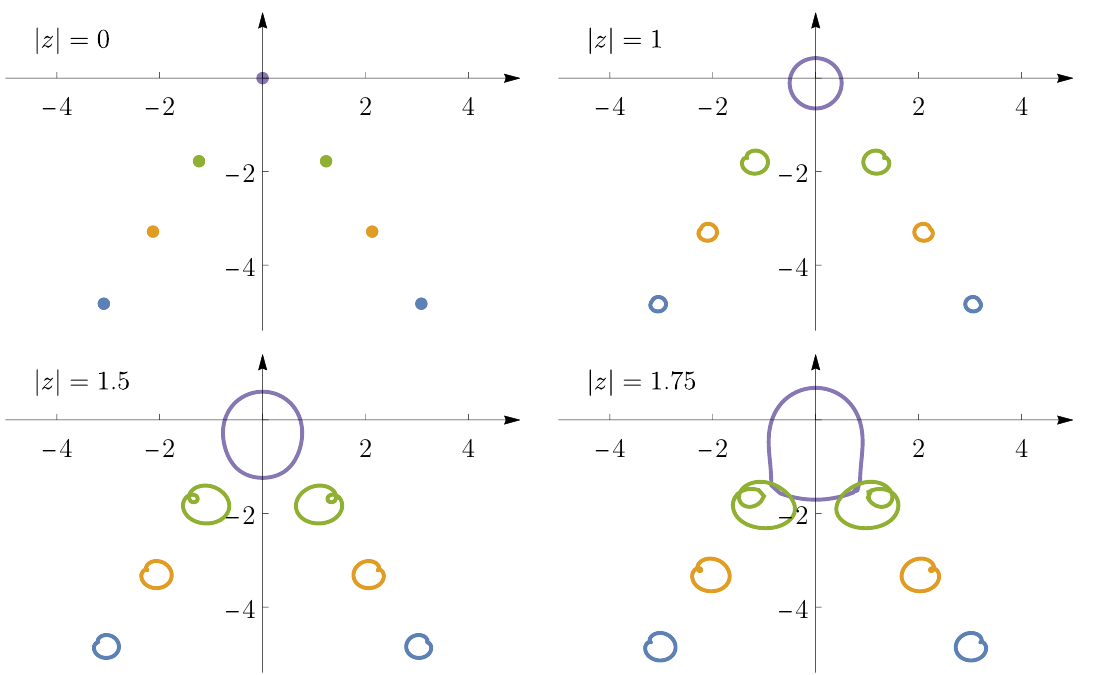
Figure 6. Quasinormal mode solutions of the spectral curve equation P ( w , z ) = 0 in the complex w -plane at fixed | z | with varying Arg [ z ] ∈ [0 , 2 π ]